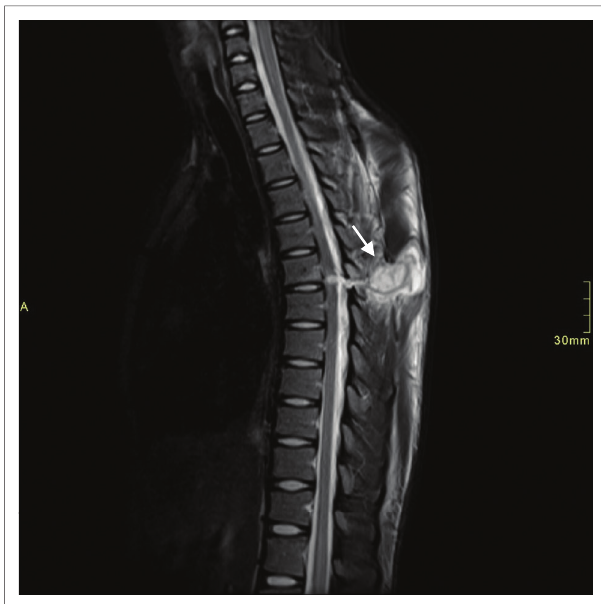
FIGURE 4: Sagittal T2 short tau inversion recovery image demonstrating pseudo- meningocele (arrow), high T2 signal wound tract, cord oedema and cord signal changes in the thoracic spine.